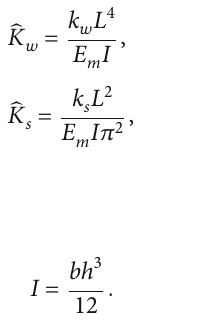
Table 2: The nondimensional frequencies ( ƛ ) of the SS FG beam placed on the two-parameter elastic medium ( ̂ K = 100